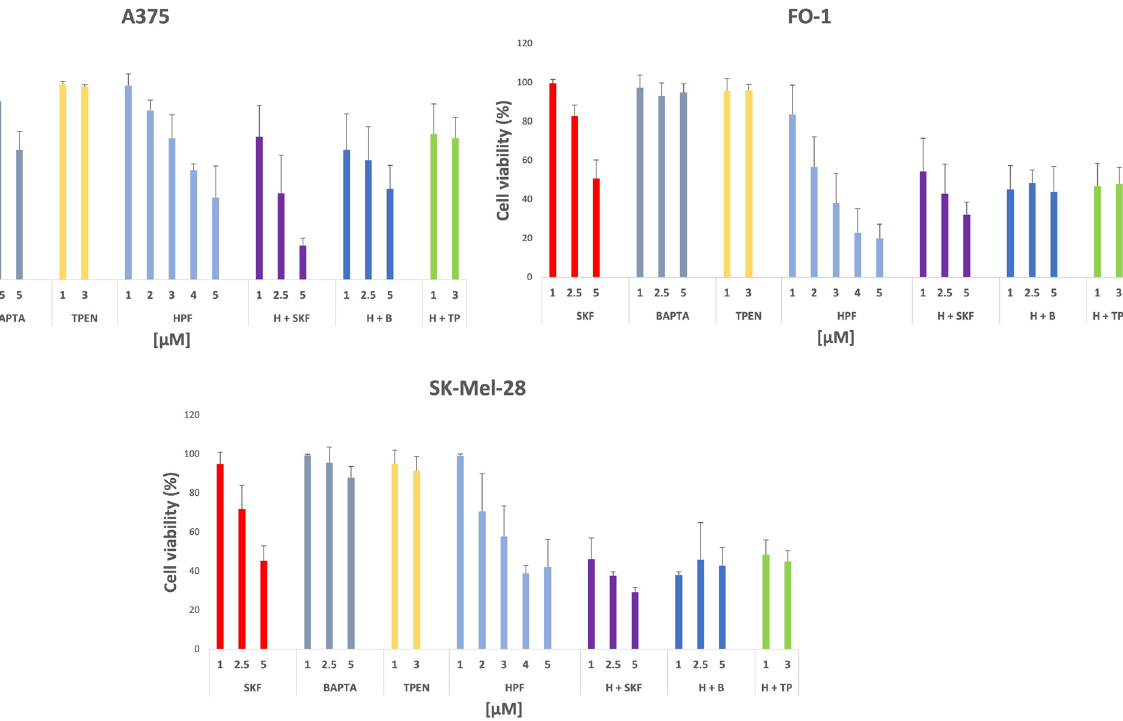
Figure 5. Histograms show the reduction in cell viability in presence of SKF, BAPTA and TPEN administered alone or in co-presence of hyperforin. SRB cell viability assay was performed on FO-1, SK-Mel-28 and A375 melanoma cells after 72 h of treatment with SKF-96365, an inhibitor of Ca ++ -channel transient receptor canonical (TRPC)-6, or BAPTA-AM, a cell-permeable Ca ++ chelator, or TPEN, a Zn ++ chelator. The co-treatment was performed with each inhibitor singly, combined with HPF used at 2 µM for FO-1 and at 4 µM for A375 and SK-Mel-28 cells, accordantly with each EC50% value previously documented. Data acquired calculating the average ± S.D. of values were obtained from at least four independent experiments.